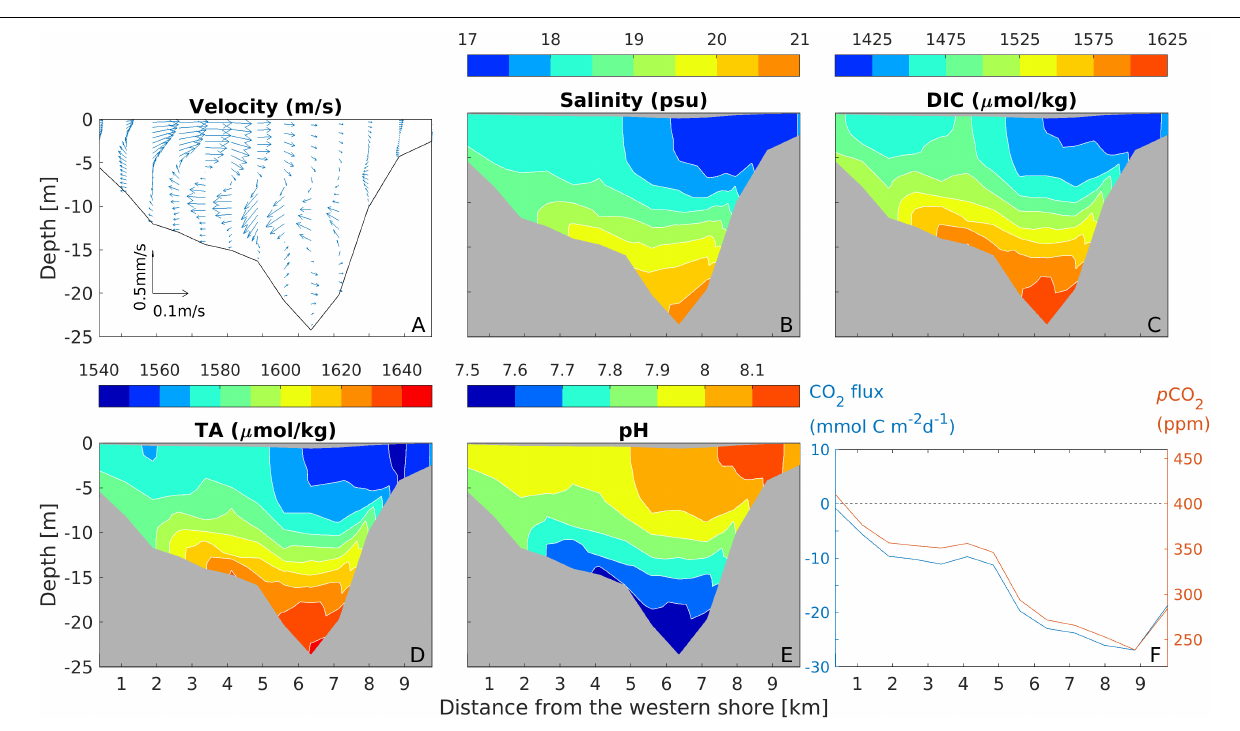
Frontiers in Marine Science |